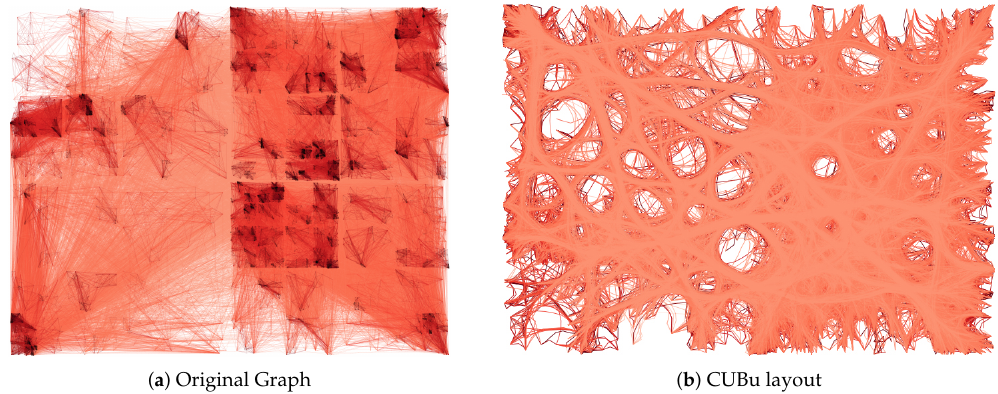
Figure 18. Original and CUBu layouts of the amazon dataset. Both layouts cannot organize edges into meaningful bundles and vertices are hidden, especially in dense areas of edges, impacting the analysis and insights that can be